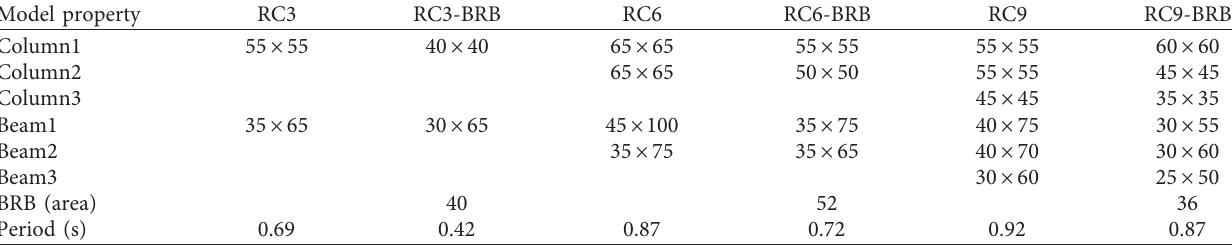
Table 2: Main properties of the six RC building models (dimensions in cm).